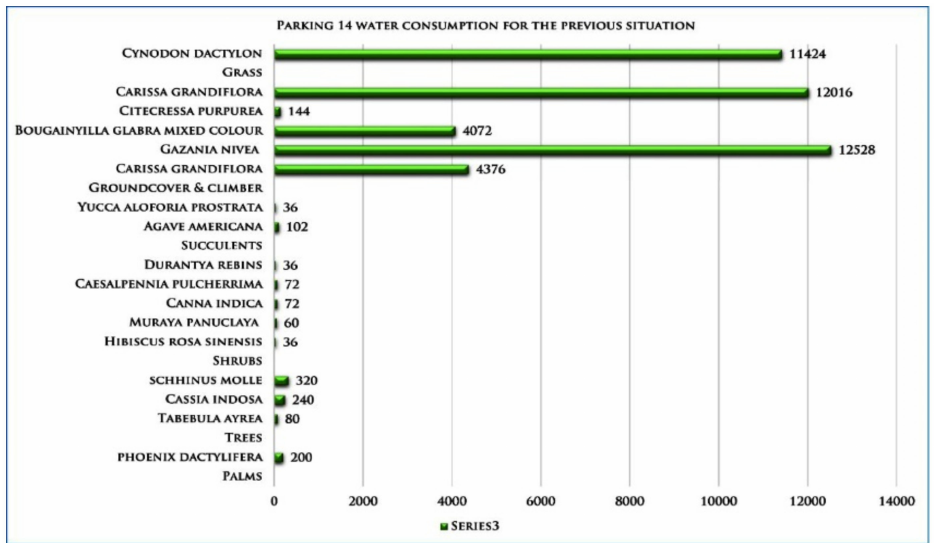
Figure 13. Experiment 1 water consumption quantity for previous status. Previous tender softscape design water consumption (Details in Table A1).